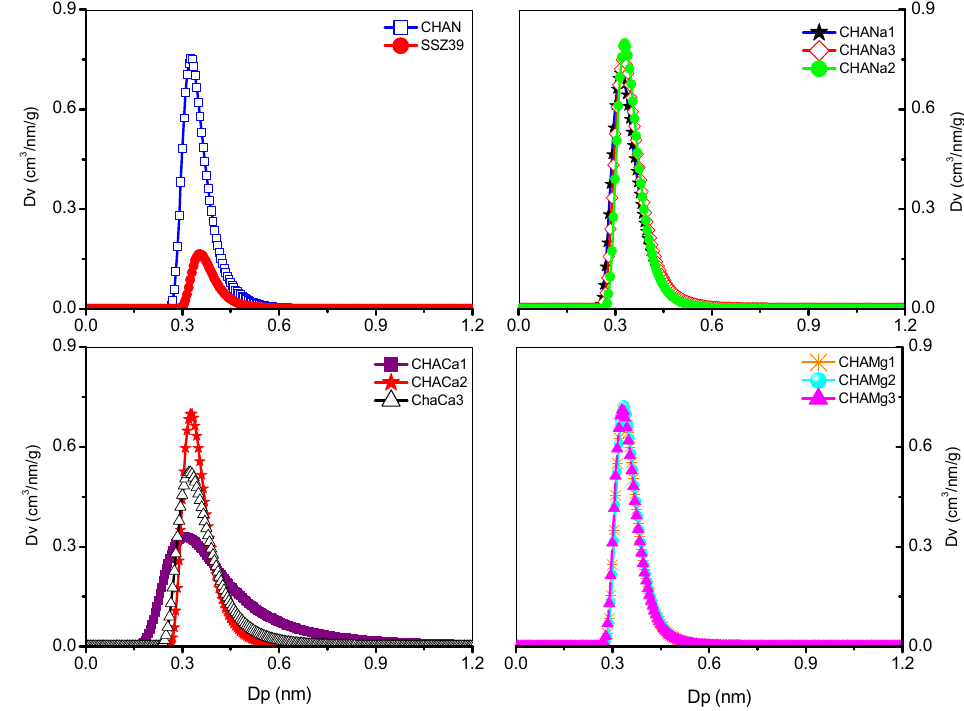
Figure 5. Nanopore distribution in chabazita, Dubinin–Astakhov (DA).